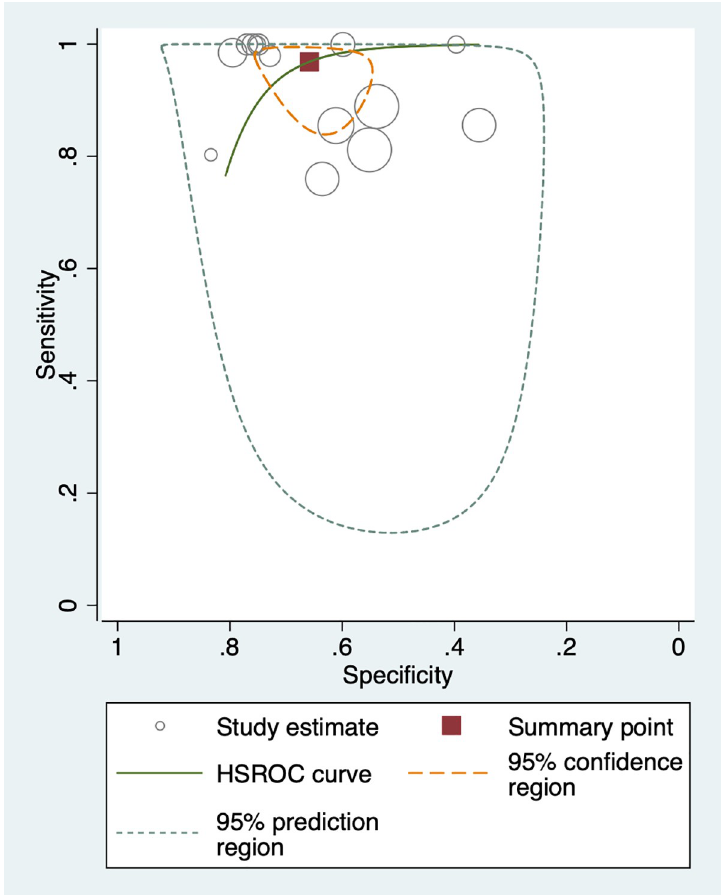
Fig 6. HSROC curve for IHA ( S . japonicum with stool examination as a reference standard).